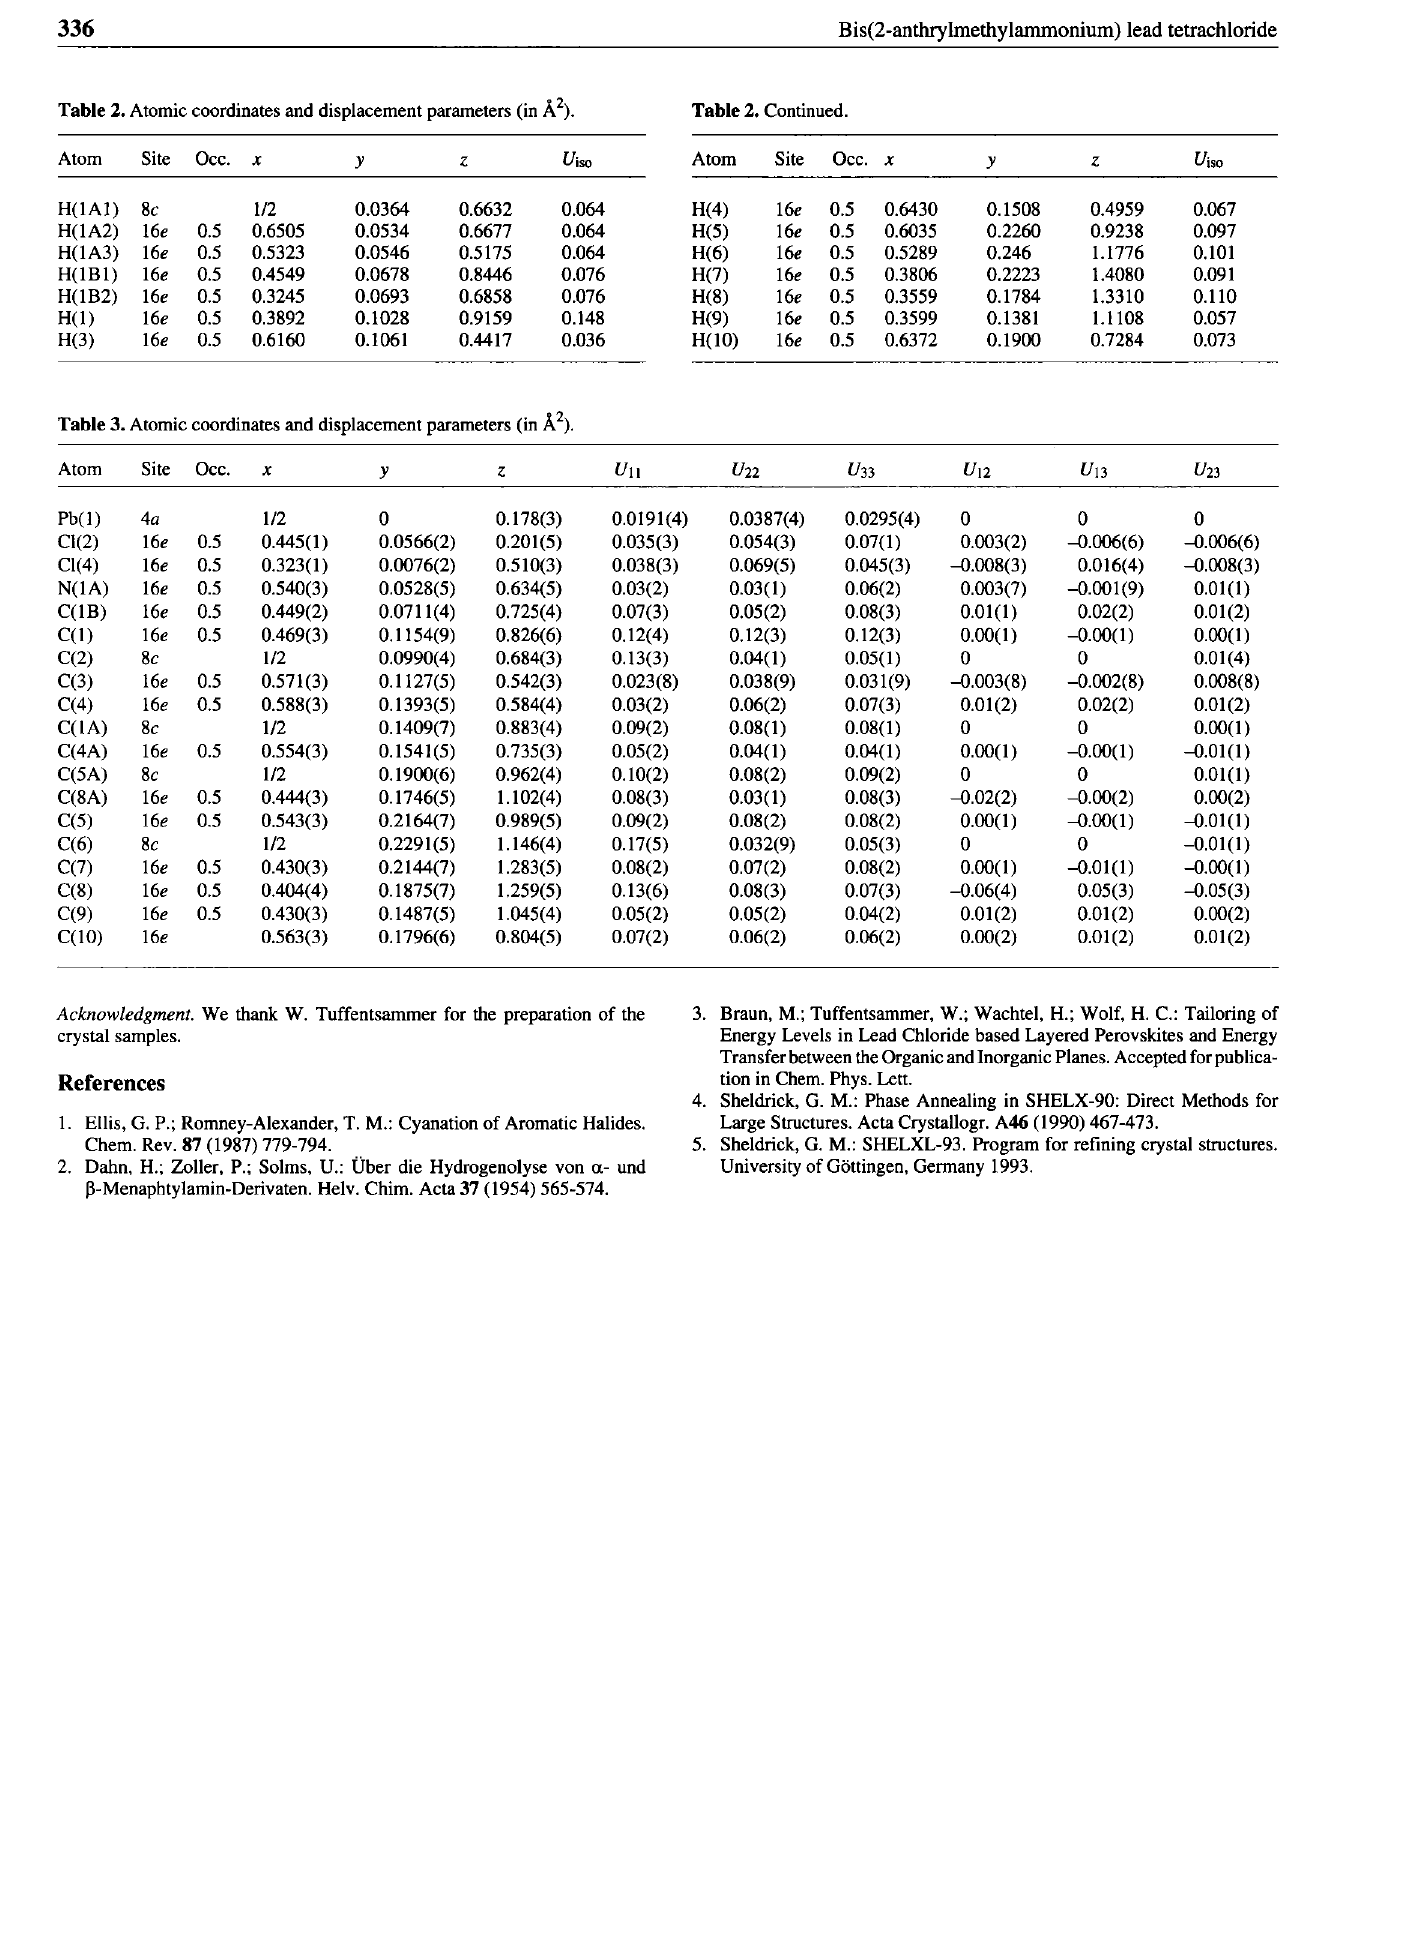
Table 2. Atomic coordinates and displacement parameters (in Ä 2 ).